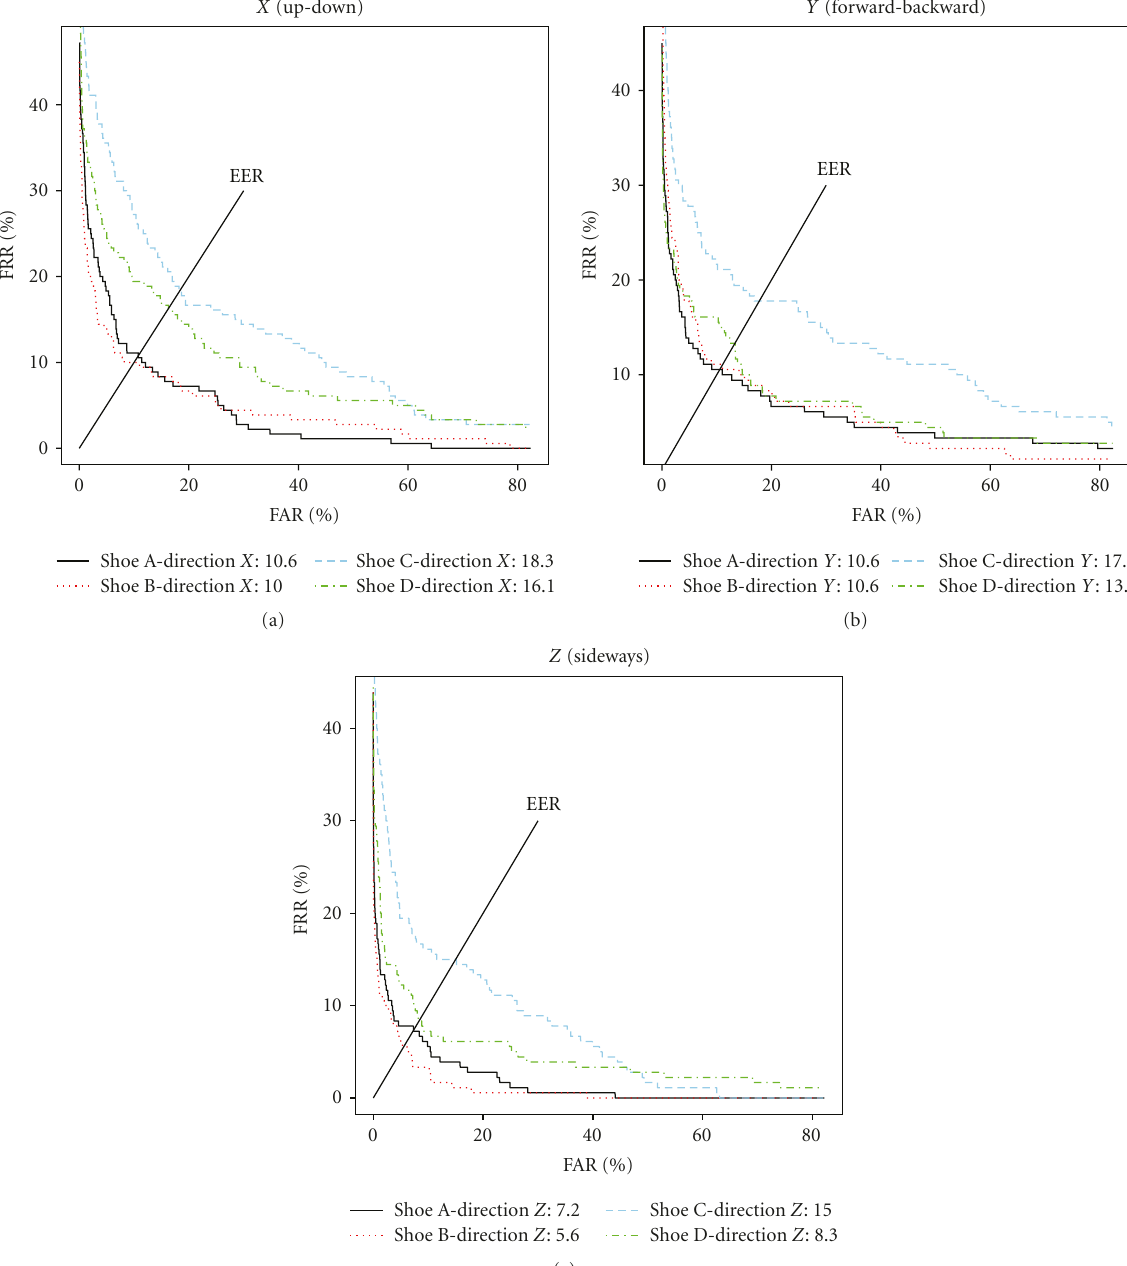
Figure 9: Authentication with respect to footwear types for each